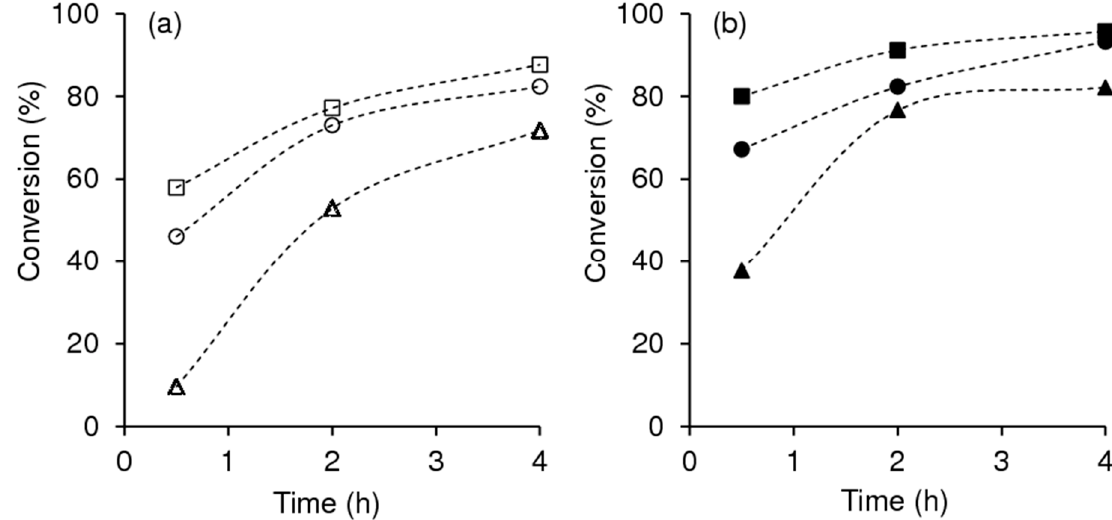
Figure 2. Kinetic profiles of the Bza/Gly reaction in the presence of 1 , at 50 °C (triangles), 70 °C (circles) and 90 °C (squares), using a catalyst load of ( a ) 3.3 g cat L − 1 or ( b ) 33 g cat L − 1 .